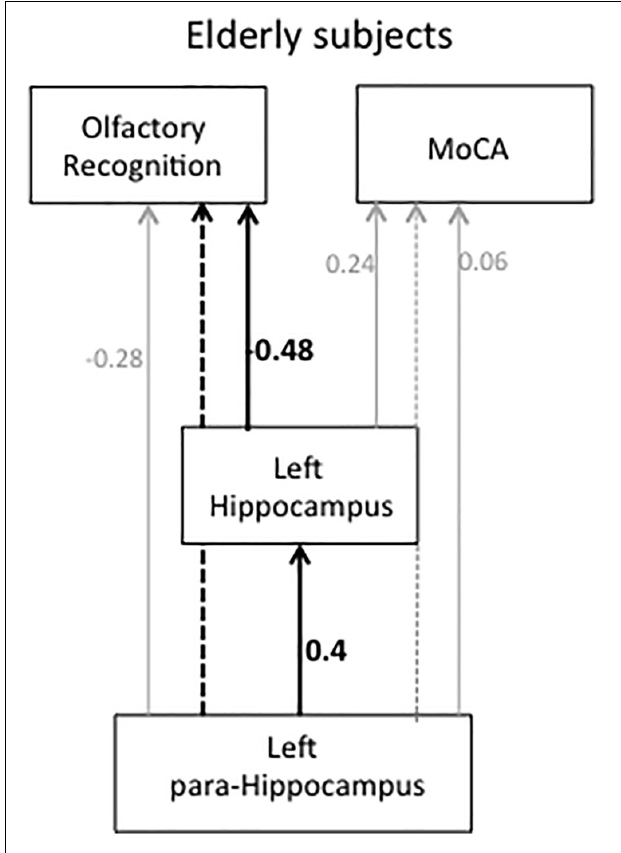
FIGURE 4 | Path diagram and standardized path coefficients for elderly subjects. The solid lines indicate a significant direct effect. The dotted line indicates a significant indirect effect. Gray solid lines indicate a non-significant direct path, and the gray dotted line indicates a non-significant indirect